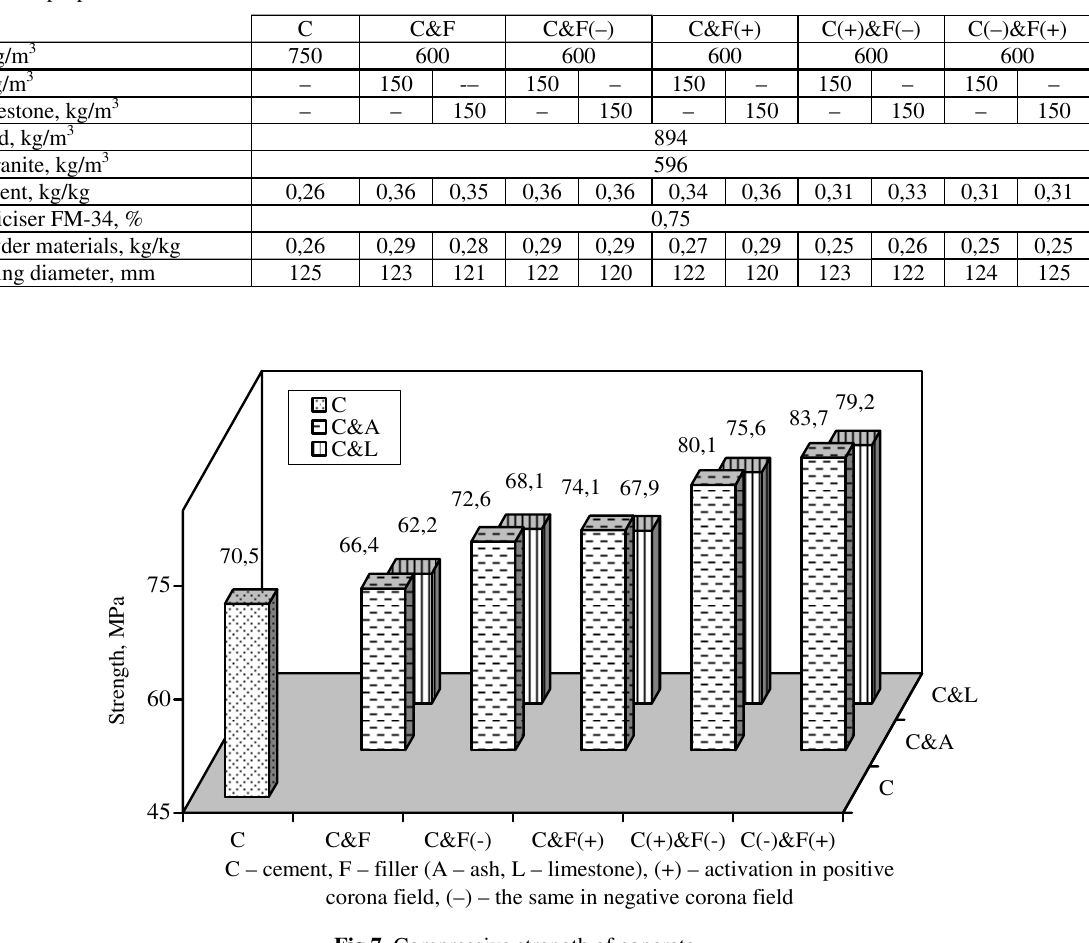
Fig 7. Compressive strength of